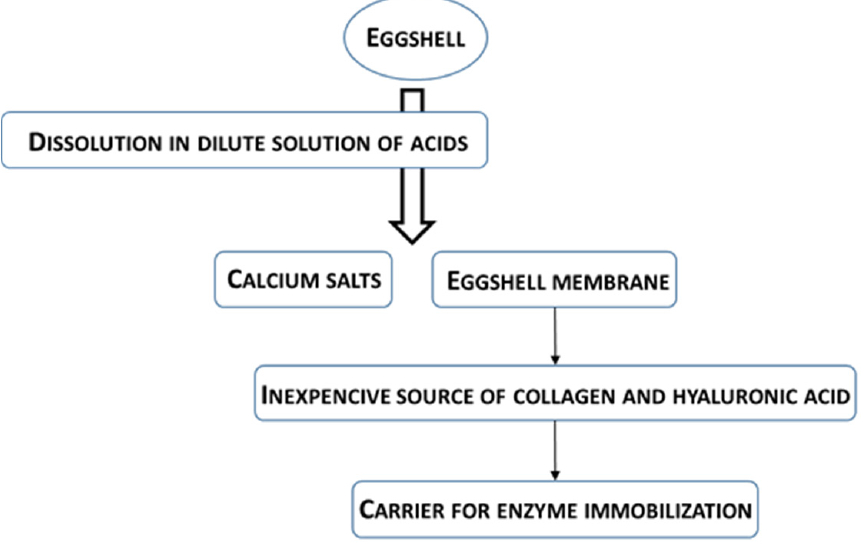
Figure 4. Schematic representation of eggshell transformation into calcium salts and membrane.